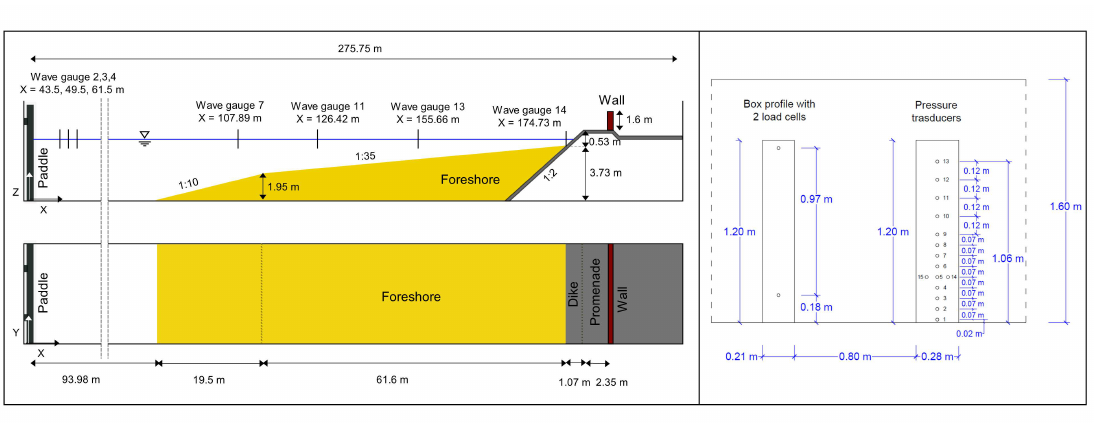
Figure 1. ( a ) Overview of the geometrical parameters of the wave flume and WALOWA model setup, with indicated WG locations. Reproduced from the work in [4], with permission from the authors, 2020. ( b ) Front view of the vertical wall on the promenade with indication of the LCs and PS